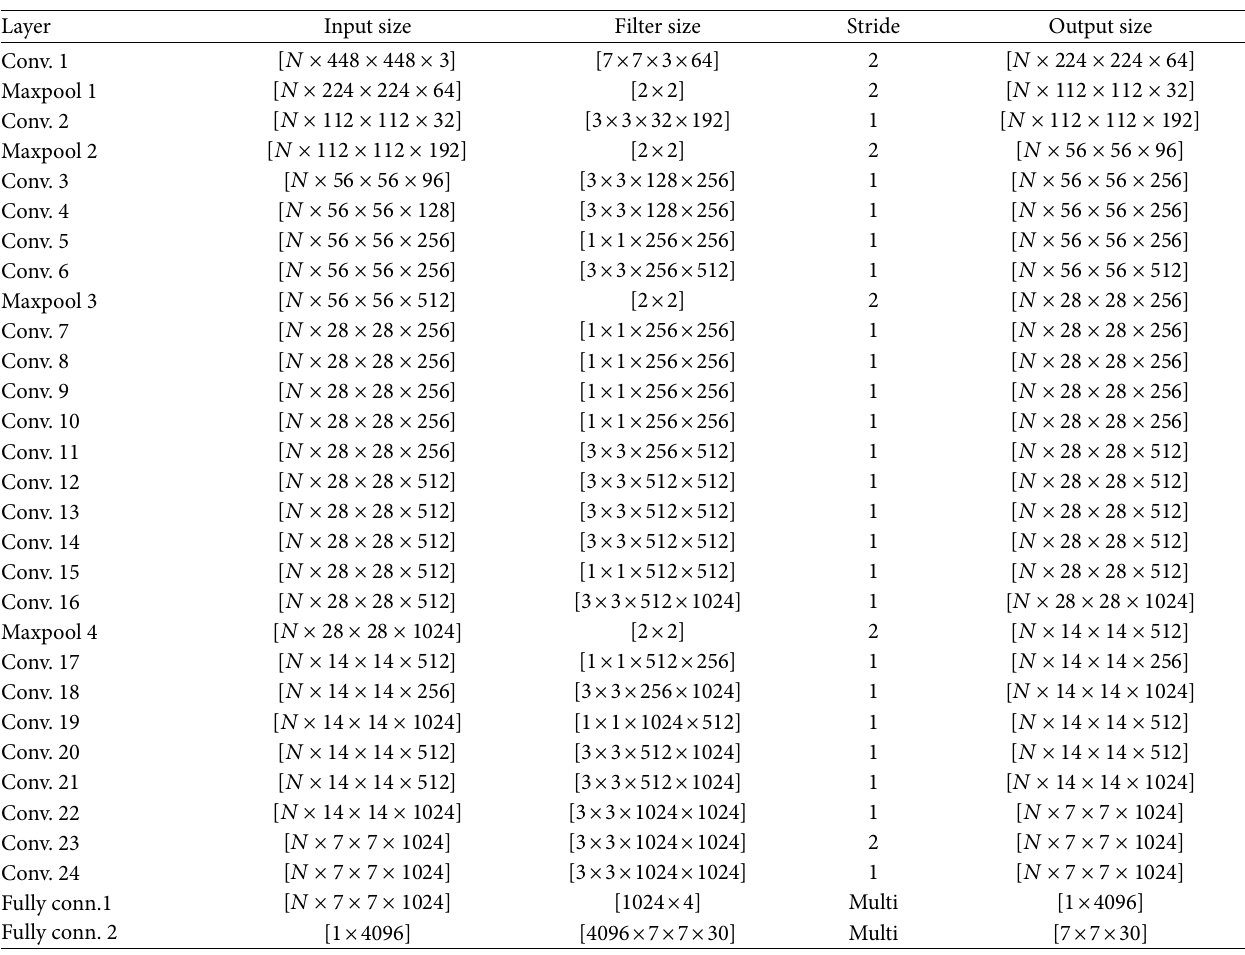
Table 1: Parameters in CNN model with image segmentation.